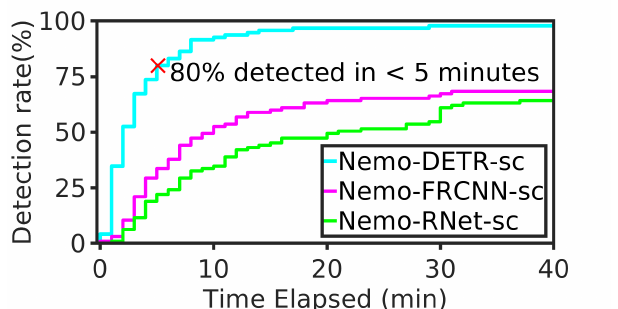
Figure 13. Cumulative detection rate vs. time elapsed after ignition. The Y-axis shows the cumulative percentage of the first correct detection within the X-axis minutes. The example marked in red shows that in 80% of the video sequences, DETR detected smoke correctly within 5 min from start of the incipient stage. 91.6% of the fires are detected within 8